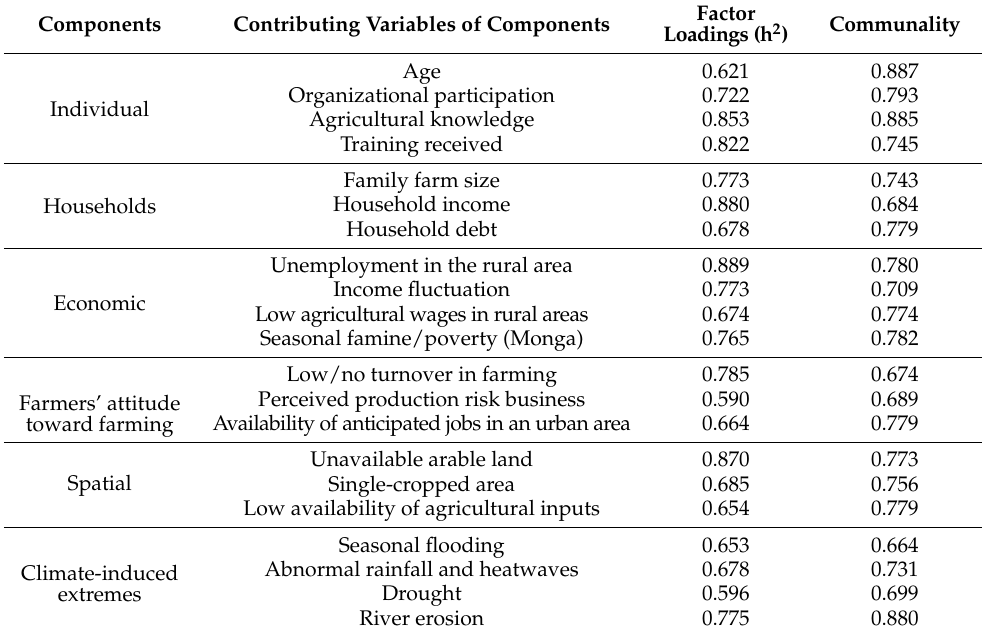
Table 3. Factor loadings and communality values of contributing variables under each factor ( n =